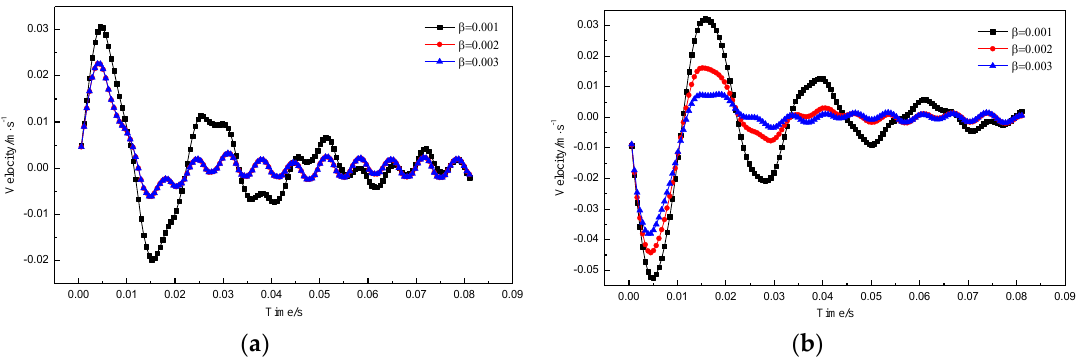
Figure 8. Impeller mass point velocity versus time with different stiffness damping coefficient: ( a ) X direction; ( b ) Y direction.